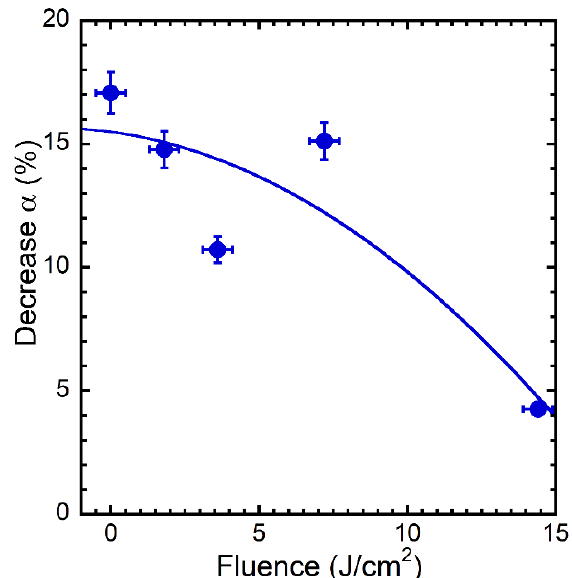
Figure 19. Decrease (expressed in percentage) of the solar absorptance α for the different samples after the thermal annealing with respect to the not annealed α values measured as a function of the laser fluence.